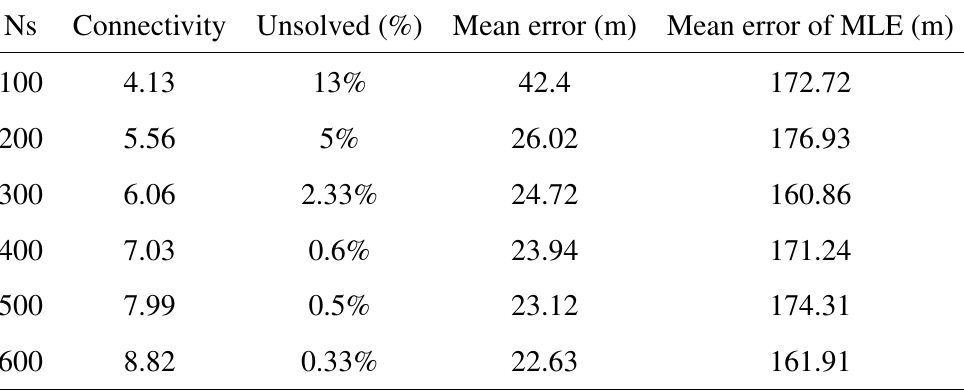
Table 3. Sensor deployment parameters and accuracy performance of the proposed algorithm versus MLE on a 350 m by 350 m square